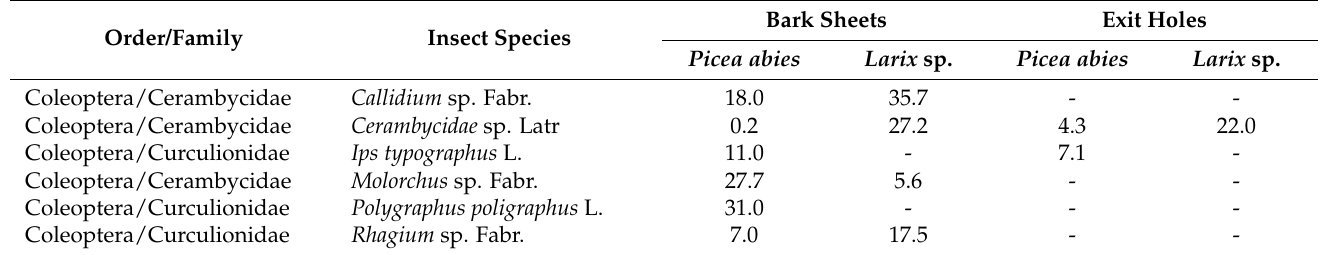
Table 5. Relative abundance (%) of xylophagous insects colonizing dead wood of Picea abies and/or Larix sp. detected using bark sheet and exit holes